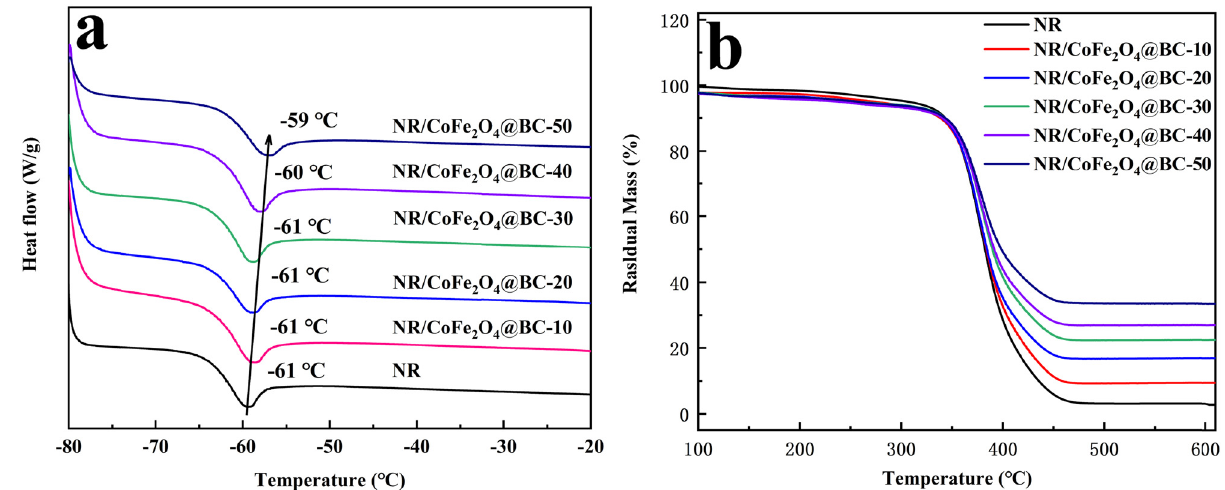
Figure 6: ( a ) DSC and ( b ) TG curves of NR composite with di ff erent CoFe 2 O 4 @BC